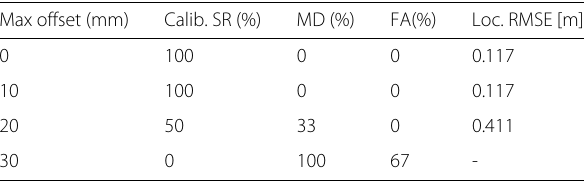
Table 4 Measures for various internal calibration